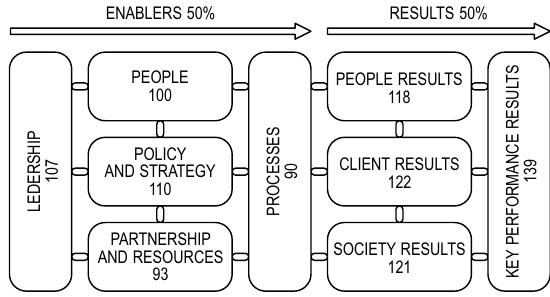
Fig. 8. New weights for the EFQM model’s use in the construction